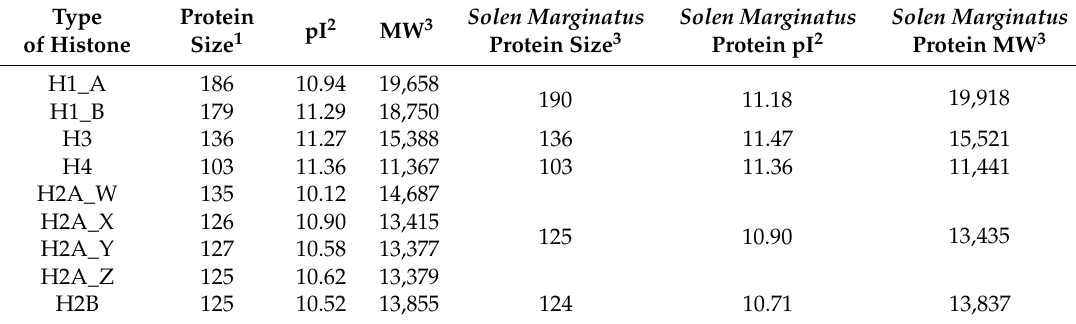
Table 3. Summary of properties of Lucina pectinata histone proteins.